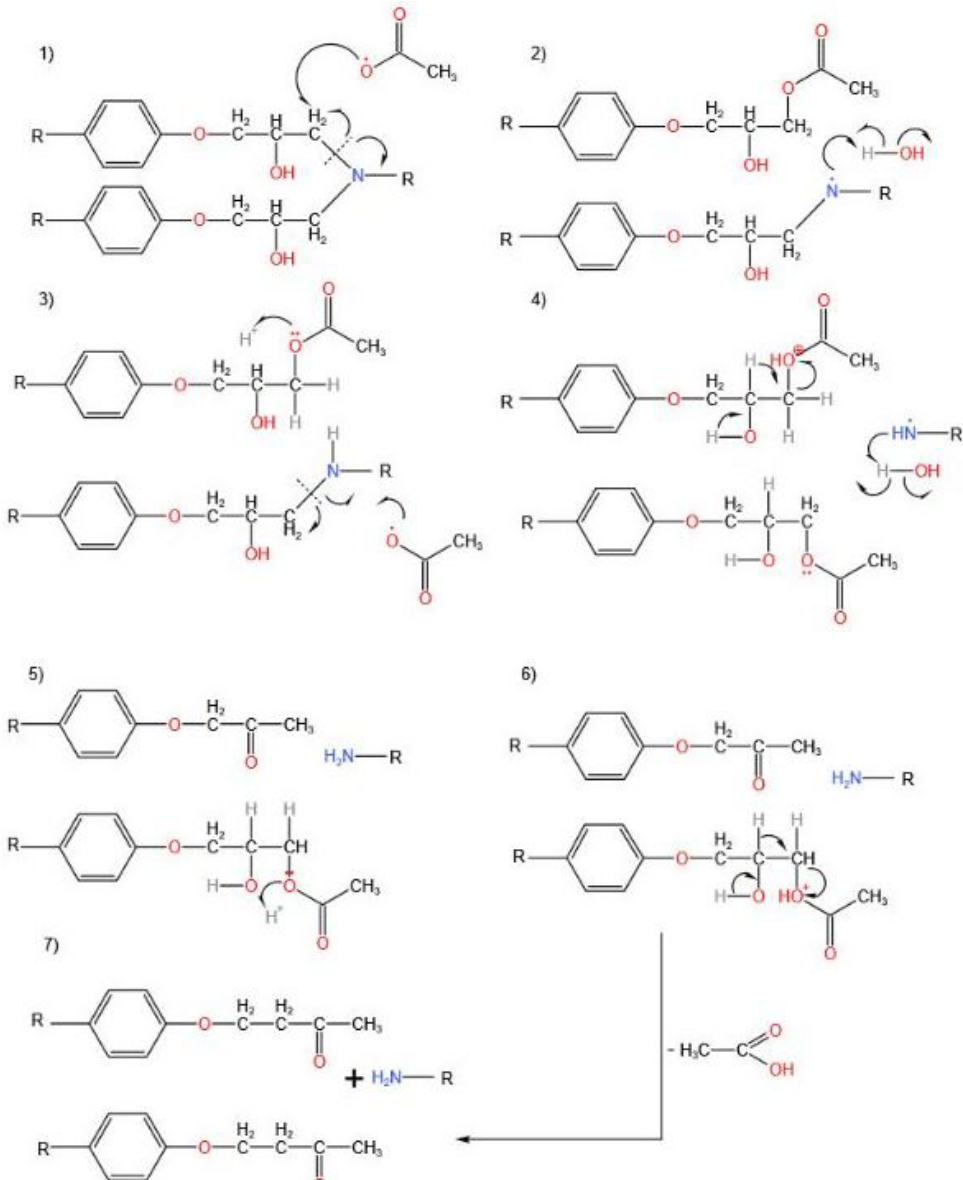
Figure 4. Reaction mechanism of decomposition of amine crosslinked epoxy by acyloxy